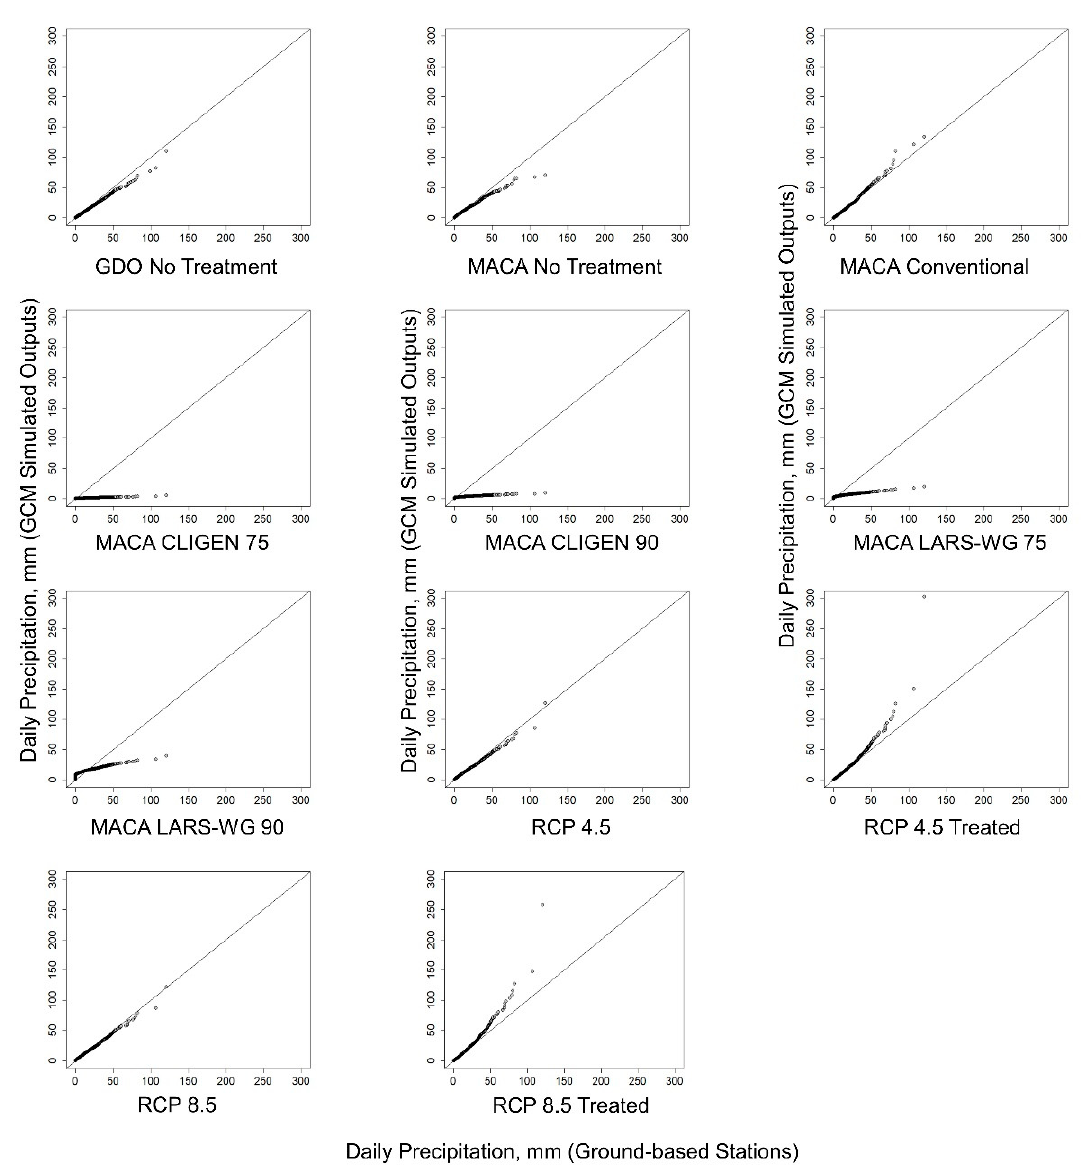
Figure 5. Q-Q plots to evaluate the performance of different bias correction methods for period between 1966 and 2005 to reduce the bias in simulating values for daily precipitation, mm and to present the future climatic scenarios (2006–2099) for Adrian, MI.